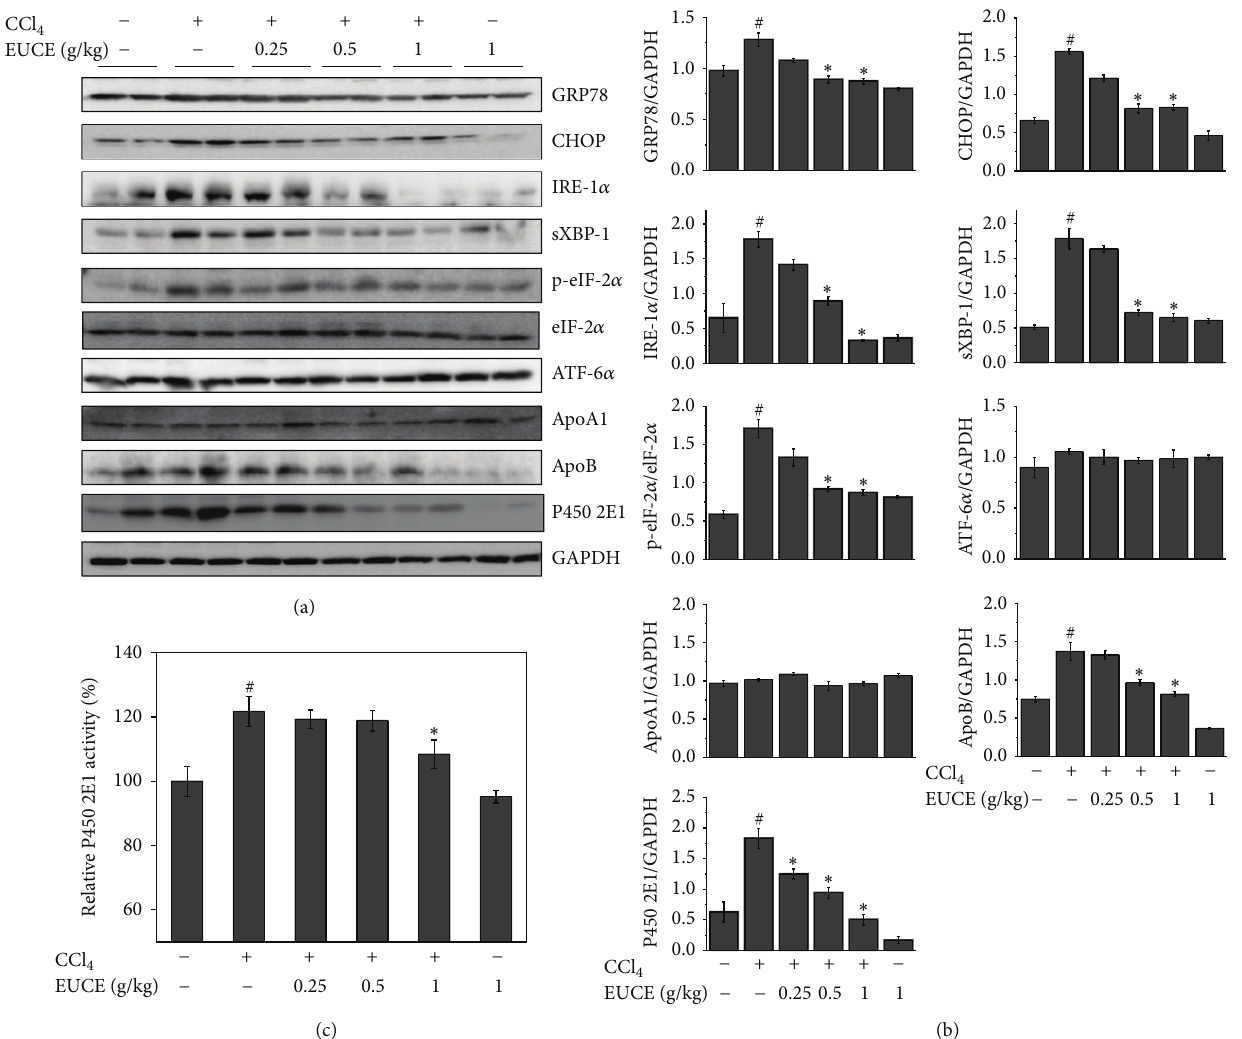
Figure 4: Effect of EUCE on CCl 4 -induced ER stress response and expression of ApoB and P450 2E1. Rats were injected with 1mg/kg CCl 4 , and livers were isolated after 4 hours. (a) Western blotting was performed on liver protein extracts with anti-GRP78, CHOP, p-eIF-2 𝛼 , eIF-2 𝛼 , ATF-6 𝛼 , IRE-1 𝛼 , sXBP-1, ApoA1, ApoB, P450 2E1, or GAPDH. (b) Graphs showing quantification of (a). (c) P450 2E1 activity was measured in liver. Asterisks indicate differences from the group treated with CCl 4 only ( ∗ 𝑃 < 0.05 ). # 𝑃 < 0.05 indicates a significant difference compared with the control